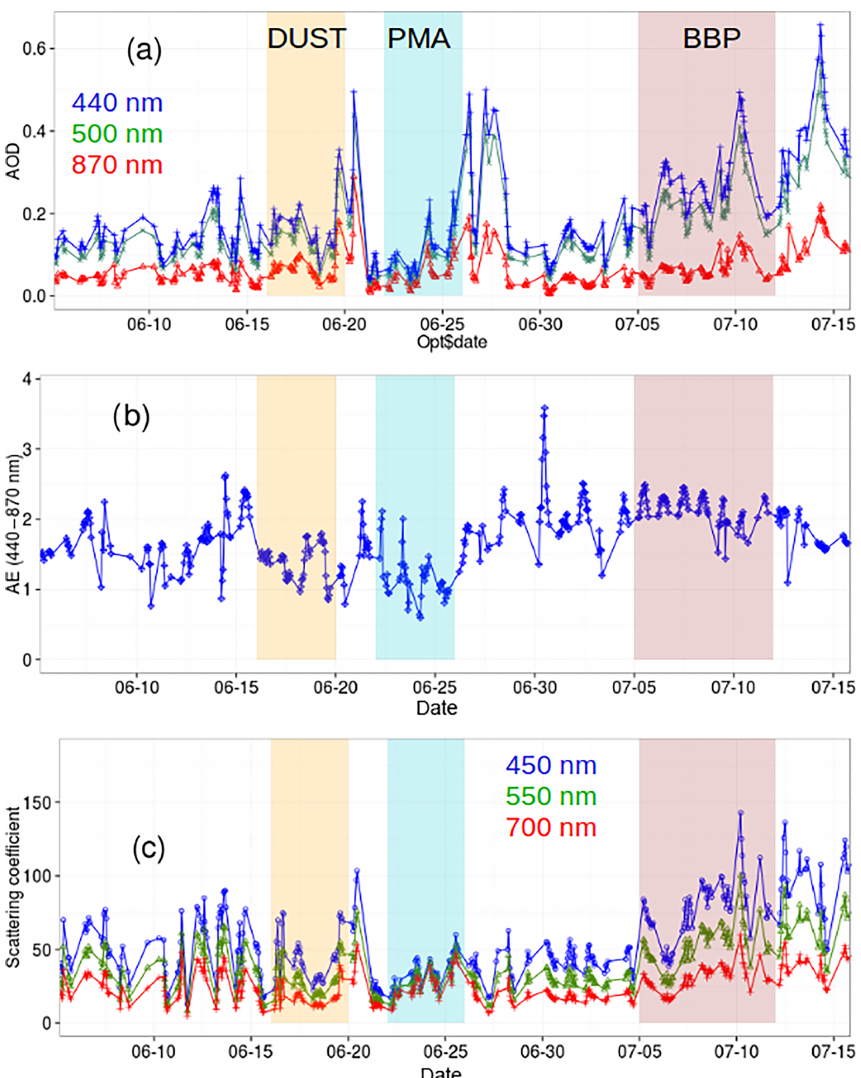
Figure 14. Time series of (a) aerosol optical depth (AOD) at three wavelengths (440, 500 and 870nm) measured by the radiometer from the AERONET network situated at the Semaphore during the ADRIMED campaign, (b) Ångström exponent calculated from AERONET data, during the ADRIMED campaign, using the extinction measurements at 440 and 870nm, (c) Scattering coefficient at three wavelengths: 450nm (blue), 550nm (green) and 700nm (red) measured by the nephelometer situated at